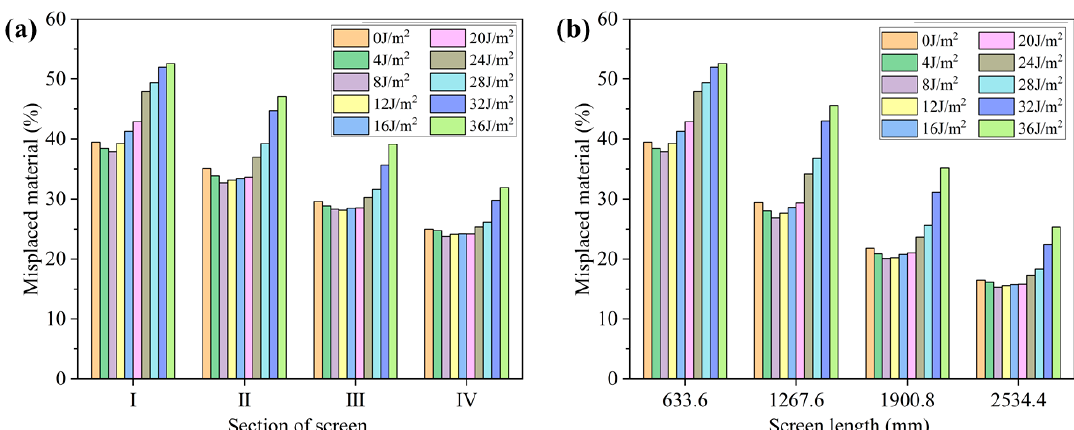
Figure 11. ( a ) Screening efficiency of different sections of the screen with different surface energy levels, ( b ) screening efficiency of different screen lengths with different surface energy levels.